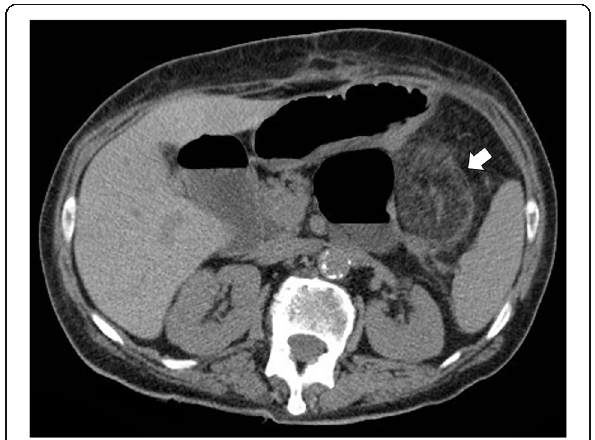
Fig. 13 Acute omental infarction in a 67-year-old woman with previous history of total colectomy. Axial non-contrast CT image shows a 6.0 cm heterogeneous fatty ovoid lesion in the left upper quadrant (arrow), associated with inflammatory changes in the nearby fatty tissue